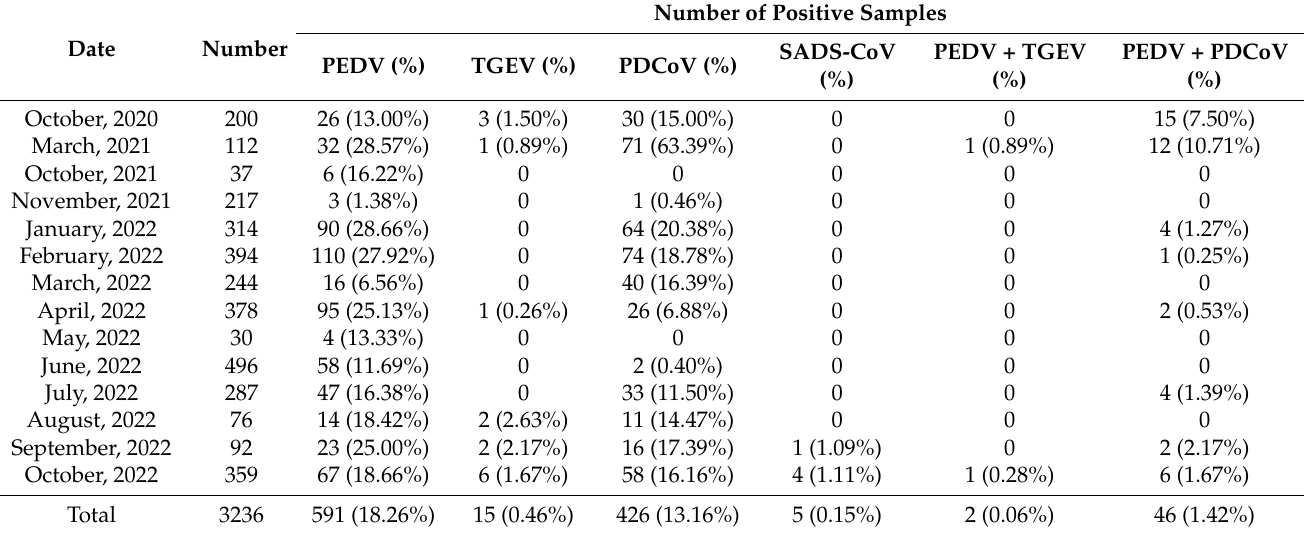
Table 4. Evaluation results of the clinical samples.